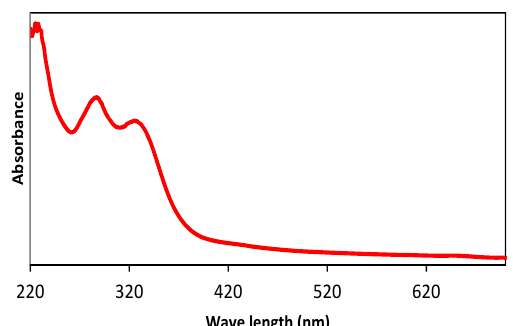
Fig. 4. UV-Vis spectrum of Oenothera biennis extract Fig. 4 UV-Vis spectrum of Oenothera biennis extract